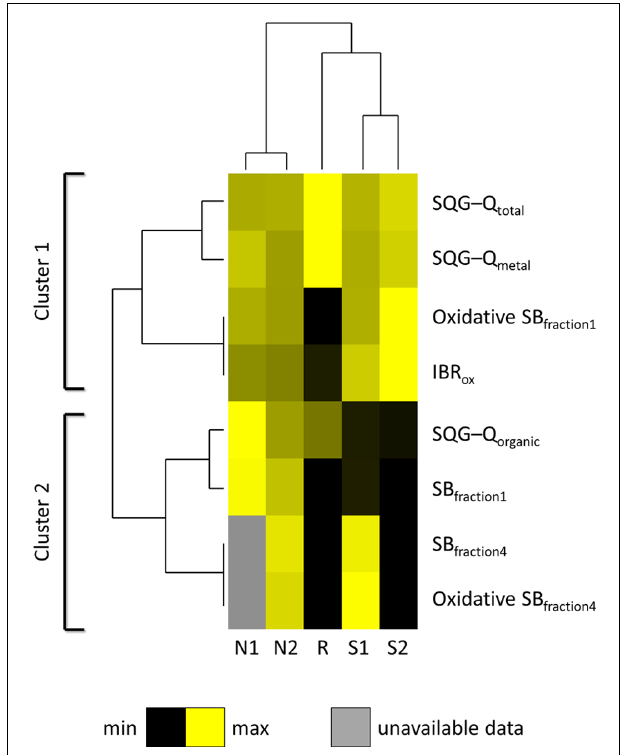
FIGURE 6 | Cluster analysis heatmap. Analysis combines sediment collection sites (N1, N2, S1, S2, and R) plus SQG-Q scores for sediment contaminants (total, metal, and organic pollutants) and biological responses: DNA strand breakage (SB), oxidative and non-oxidative, inputted as 1-EC 50 relatively to the highest %DNA in tails from the study), for HepG2 cells exposed to fractions 1 (crude extract, DCM:methanol extraction) and 4 (methanol extraction only), plus IBR for oxidative stress biomarkers combining clam, fish, and cuttlefish (IBR ox ). Clustering between endpoints was achieved taking Spearman’s rank-order correlation R as distance metric. Clustering between sites was obtained with Euclidean distances. Complete linkage as employed as amalgamation rule for the